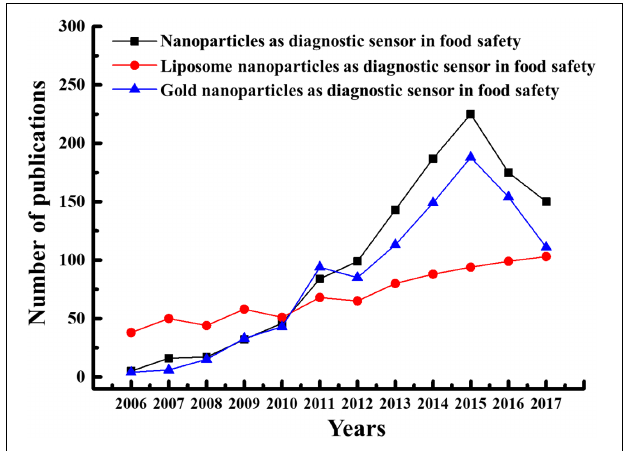
FIGURE 1 | Number of publications in last 10 years in the area of nanoscience in food